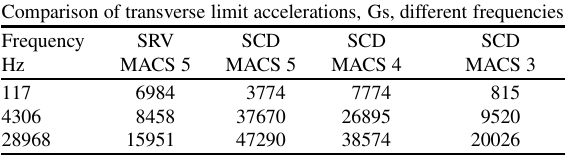
Table 5 Difference in dB’s between different data sets, transverse Delta dB: Near-tactical and Soft Catch Data,